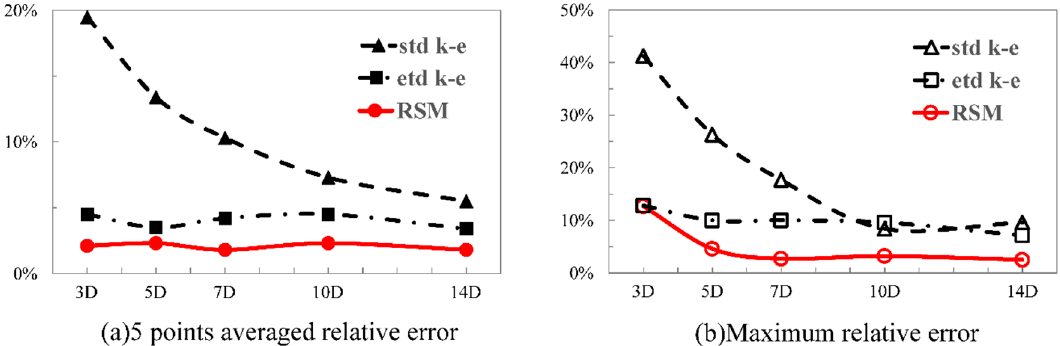
Figure 11. Simulation’s relative error of TI, ( a ) 5 points averaged relative error; ( b ) maximum relative error.